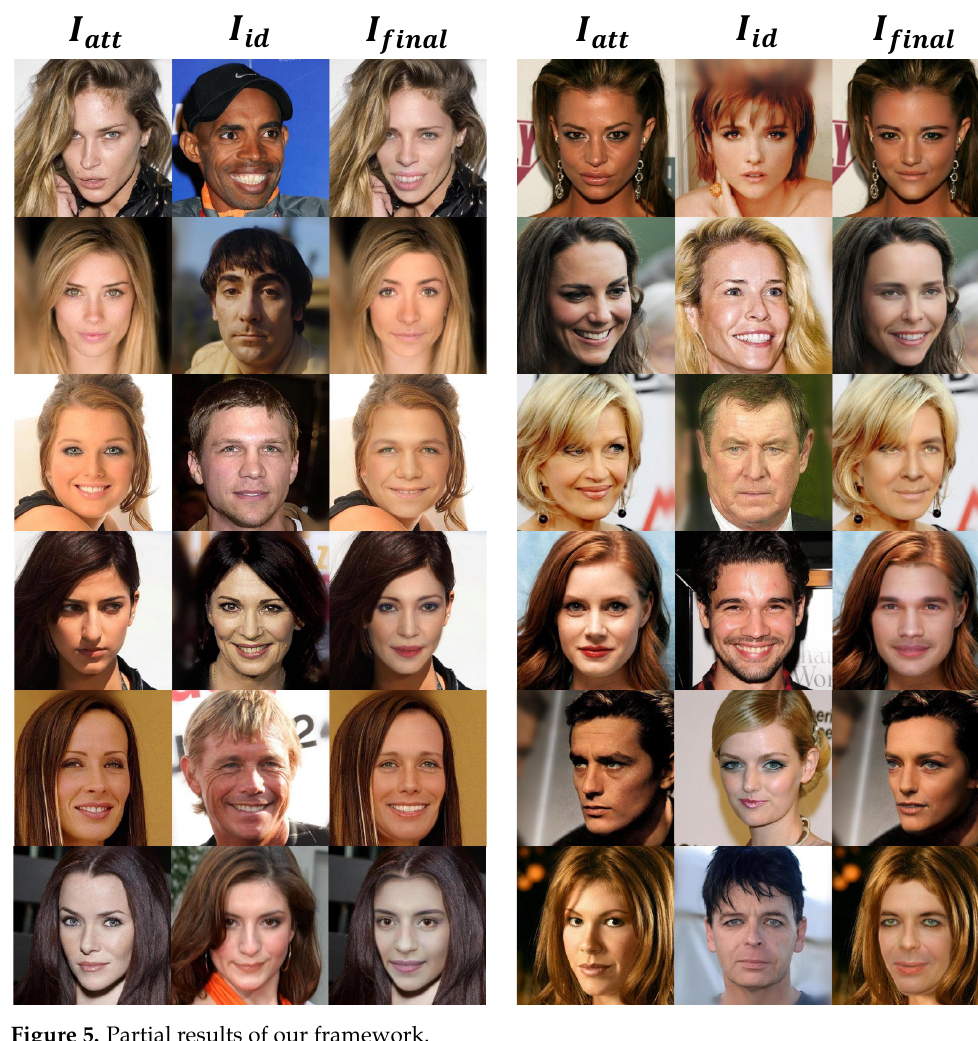
Figure 5. Partial results of our framework.